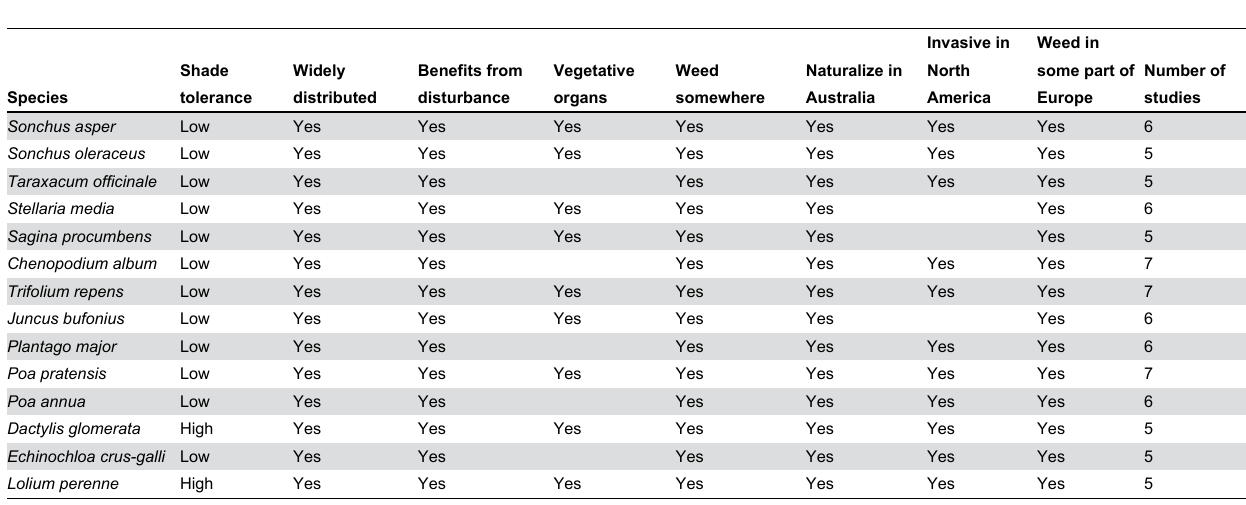
Table 4. The extent of the distribution, adaptions and weed status in Australia, North America and Europe of the most common species recorded in five or more of the 13 studies on seed from